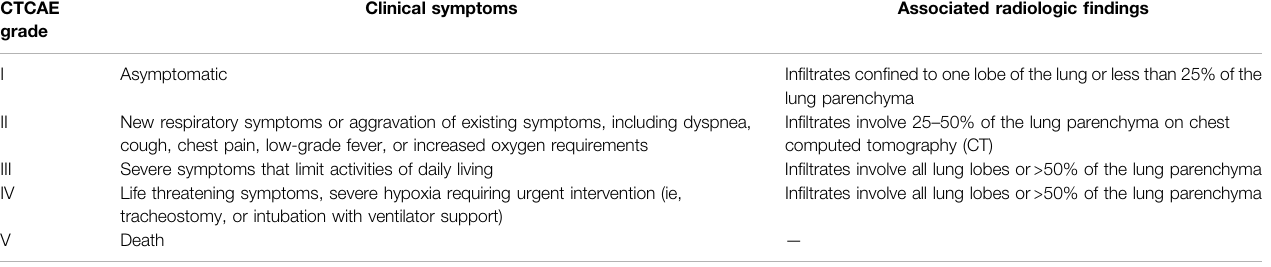
TABLE 2 | National cancer institute common terminology criteria for adverse events (CTCAE) pneumonitis grading system. CTCAE grade